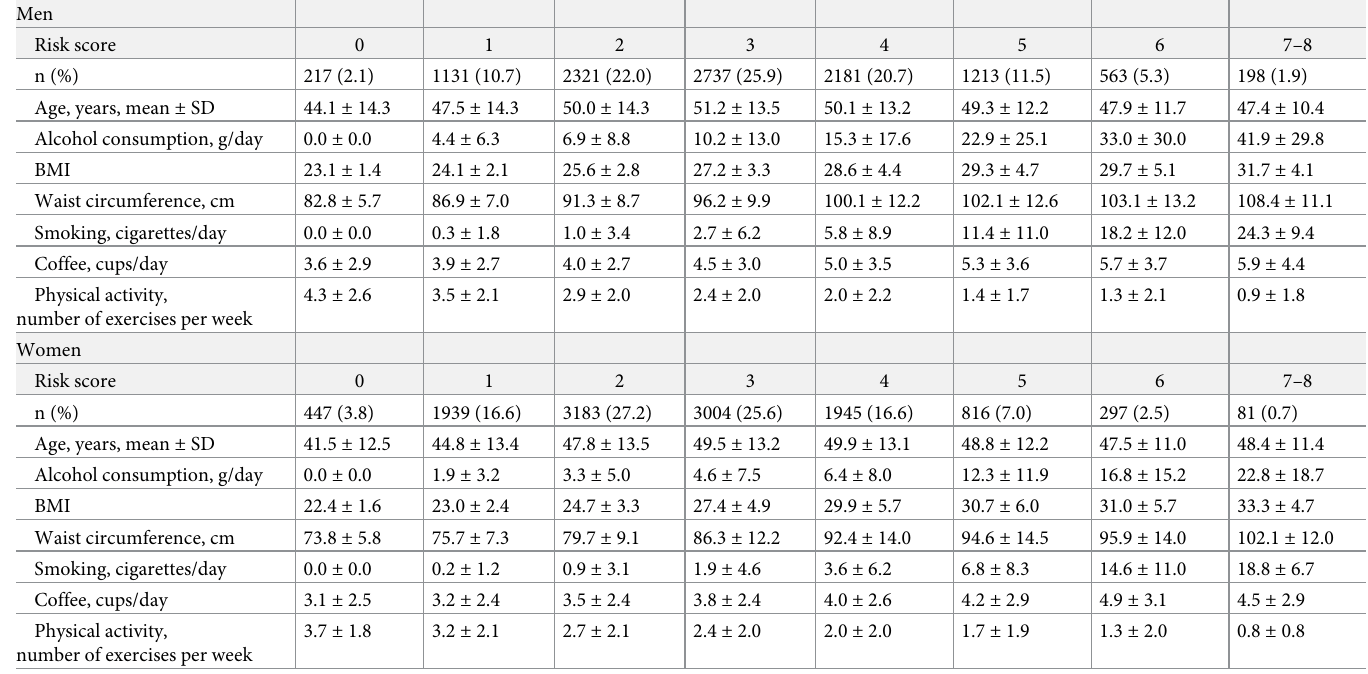
Table 1. Main characteristics of the participants, as classified according to lifestyle risk factor